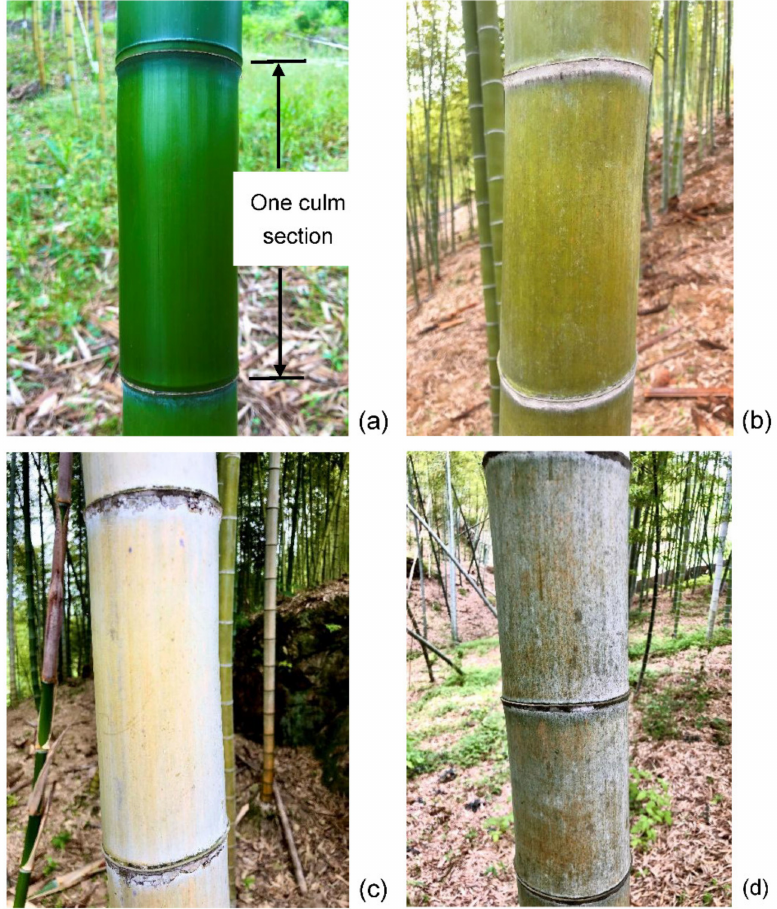
Figure 1. Photos of Moso bamboo culms of different du. ( a ) The 1-du bamboo; ( b ) The 2-du bamboo; ( c ) The 3-du bamboo; ( d ) The 4-du